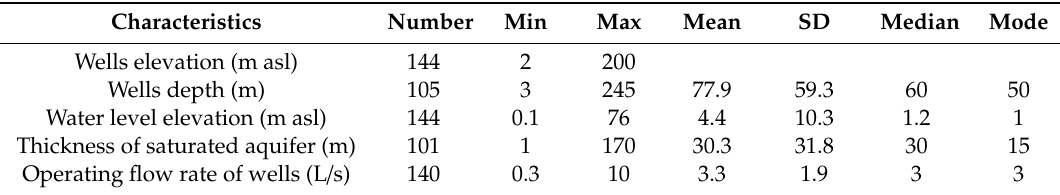
Table 1. Main characteristics of the tested